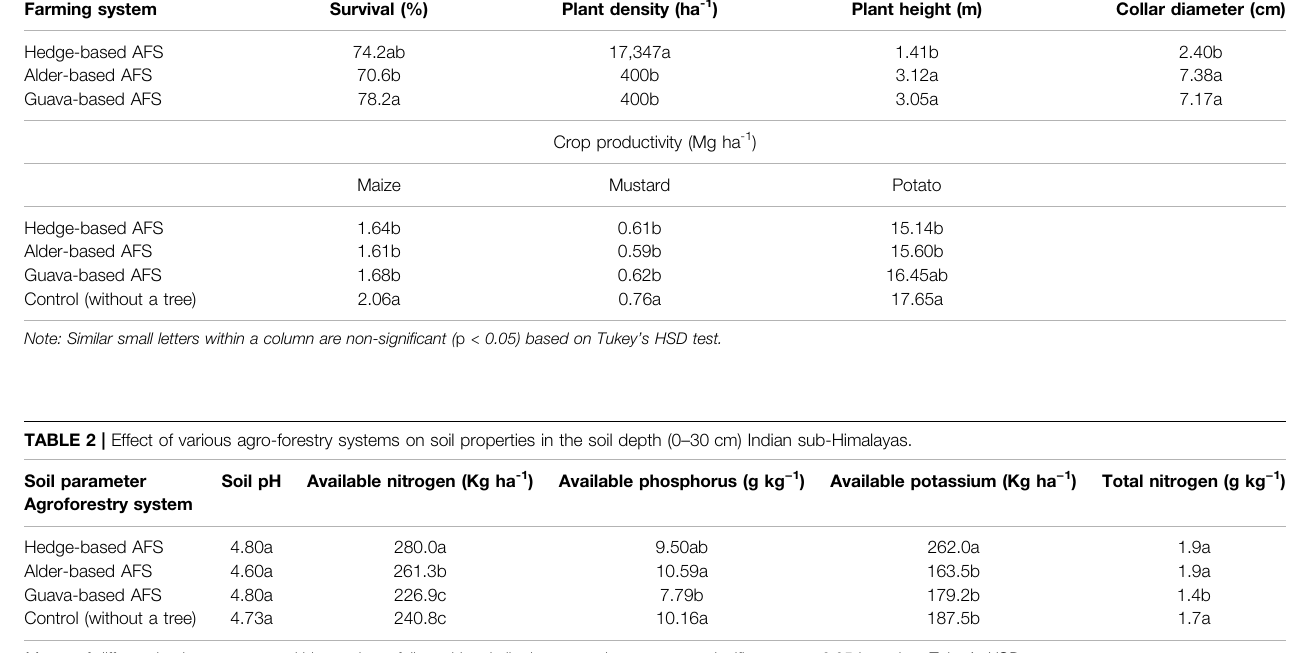
TABLE 1 | Growth performance and crop productivity in different agroforestry systems of the Indian sub-Himalayas. Farming system